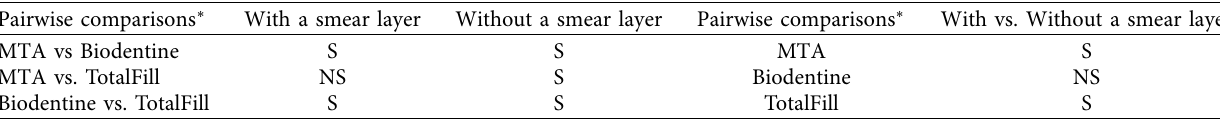
Table 3: Percentage of mode of failure for the three materials tested from the root dentin surface with (+) and without ( − ) a smear layer. Materials Root dentine surface + Smear layer Biodentine + Smear layer MTA + Smear TotalFill FS